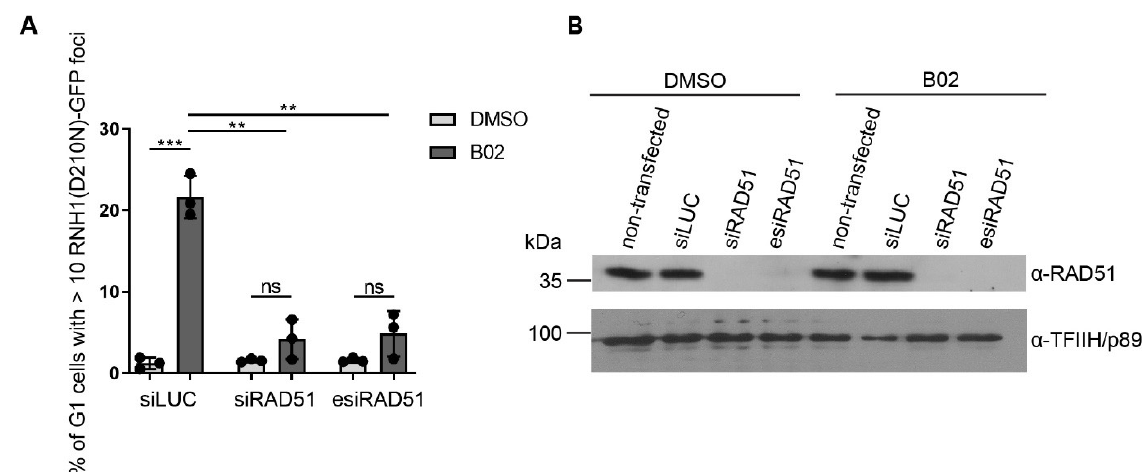
Figure 3. B02-induced R-loops are dependent on the presence of RAD51. ( A , B ) U-2-OS T-REx (RNH1(D210N)-GFP) cells were transfected with small interfering RNA (siRNA) against RAD51 (siRAD51) or a pool of endoribonuclease-prepared siRNAs (esiRNA) against RAD51 (esiRAD51) for 36 h. For the last 24 h, the cells were treated with doxycycline (1 ng/mL) and nocodazole (100 ng/mL), released from arrest for 3 h and pre-extracted before fixation. Cells were then subjected to image-based analysis of RNH1(D210N)-GFP foci. ( A ) The graph represents quantification of the fraction of G1 cells with more than 10 RNH1-GFP foci per nucleus (in %). ( B ) Protein levels were assessed by Western blot analysis. The data shown in ( A ) are pooled from two independent experiments. Statistical significance was determined using Unpaired t test (*** p < 0.005, ** p < 0.01, ns, not significant).